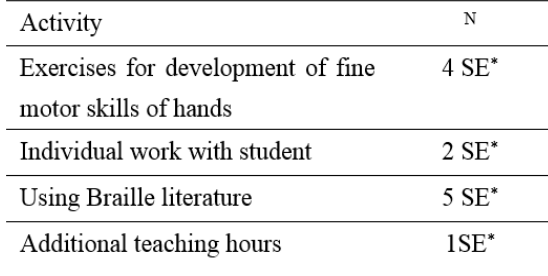
Table 2. Enhancing the learning of